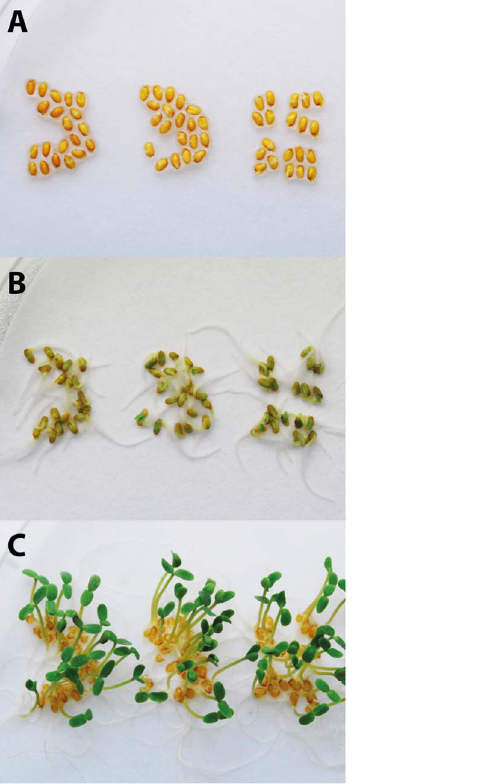
Table 2. Representative fatty acid profiles of triacylglycerol (TAG), polar lipids, free fatty acids (FFA) and diacylglycerol (DAG) in T 5 GA7 seed.